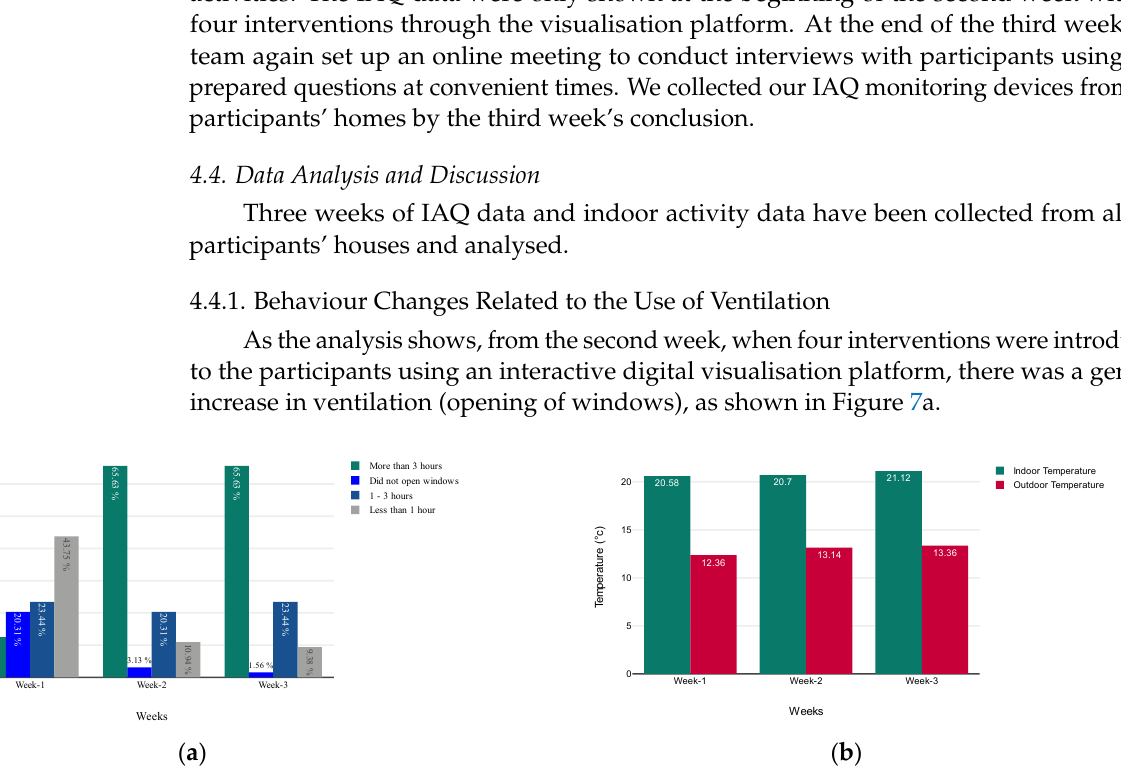
Figure 7. ( a ) Changing pattern of week-wise window opening hours; ( b ) comparative temperature plot between indoor and outdoor from different weeks.